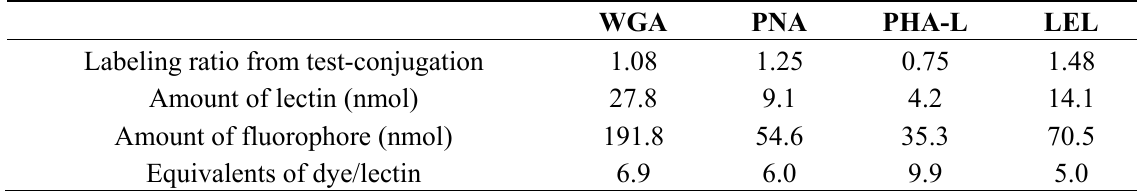
Table 3. Amounts used for final